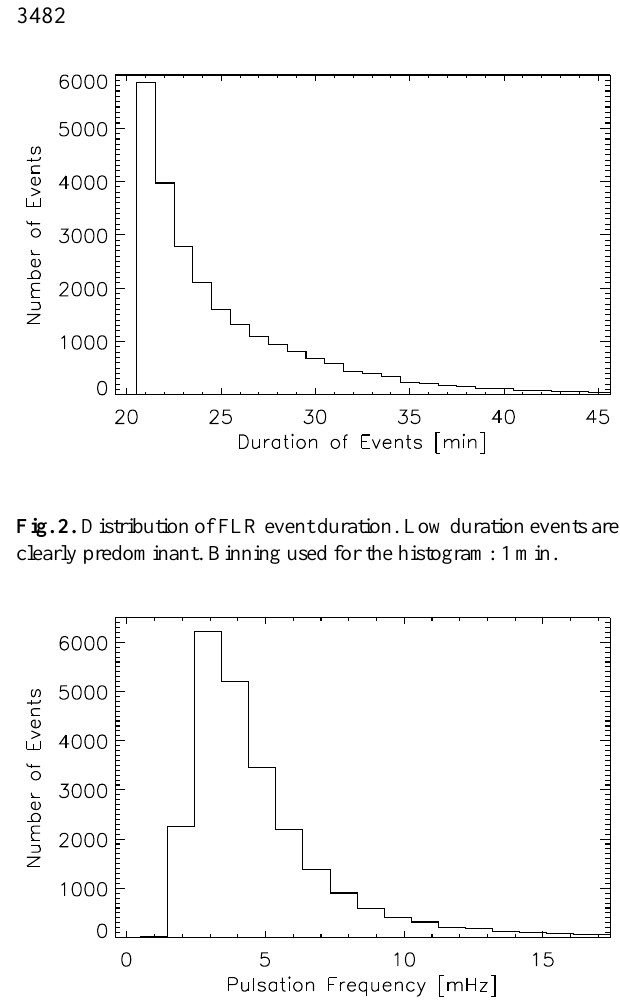
Fig. 3. Distribution of the pulsation frequency of the events ana- lyzed with the FLRD method. 3mHz oscillations are clearly pre- dominant. Binning used for the histogram: 1 / 1024s.